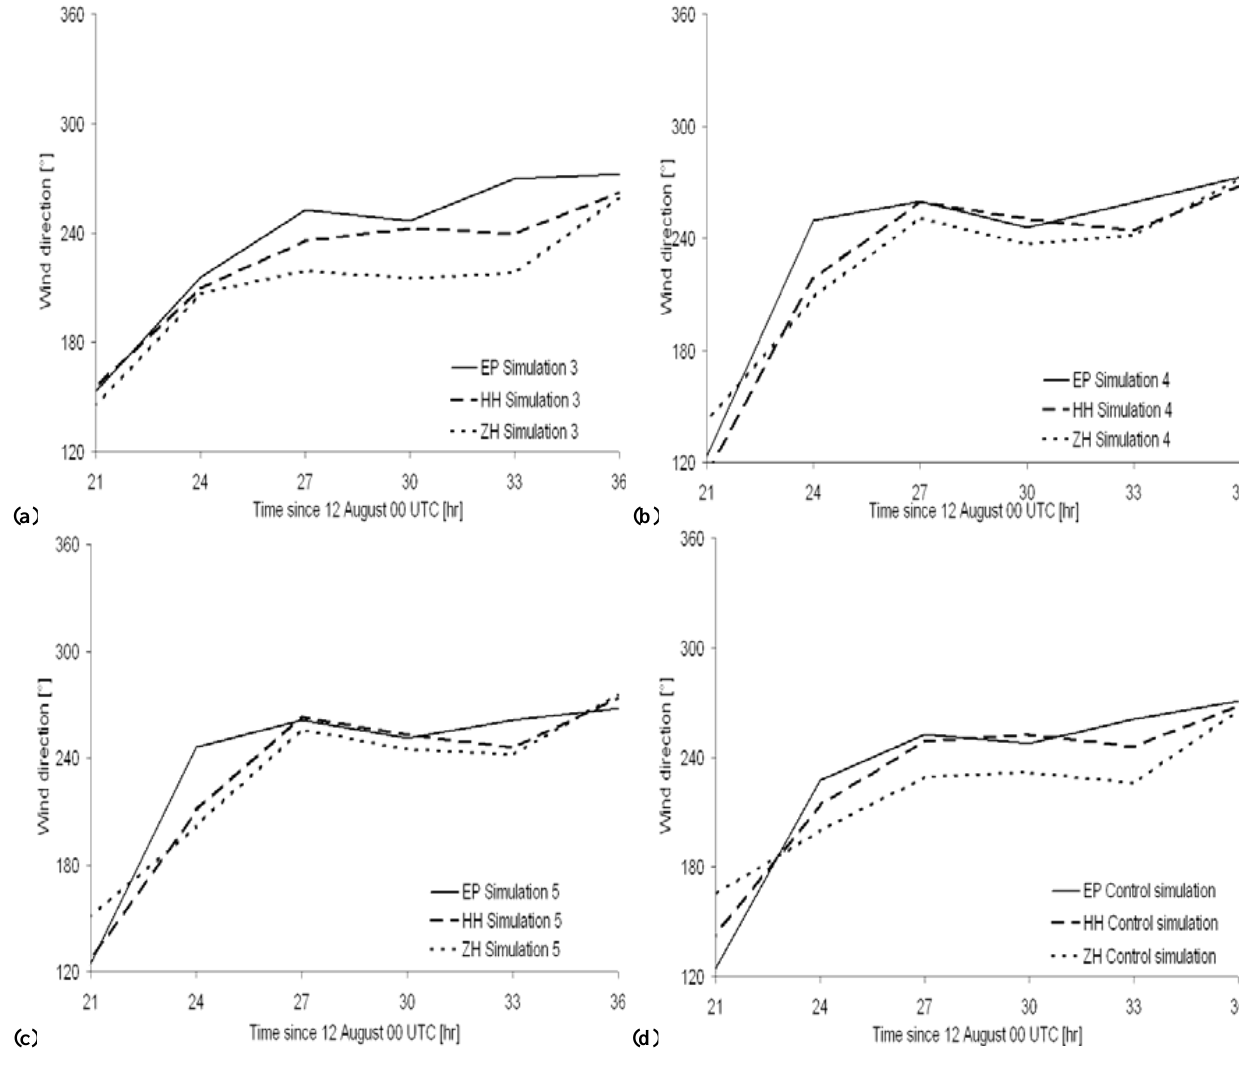
Fig. 11. Time evolution of the calculated wind direction ( ◦ ) for a sea station (Europlatform), a coastal station (Hoek van Holland) and an inland station (Zestienhoven). Simulation 3 (a) , 4 (b) and 5 (c) are compared with the control simulation (d) . Specifications of the simulations are written in Table